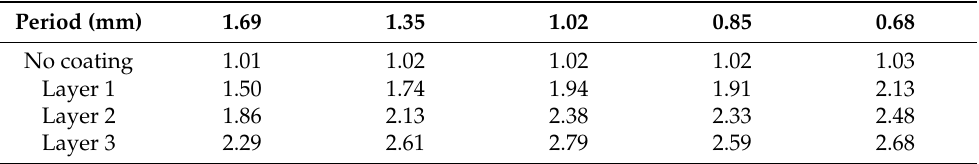
Table 1. Fitted n YN parameter of the Yule–Nielsen model.